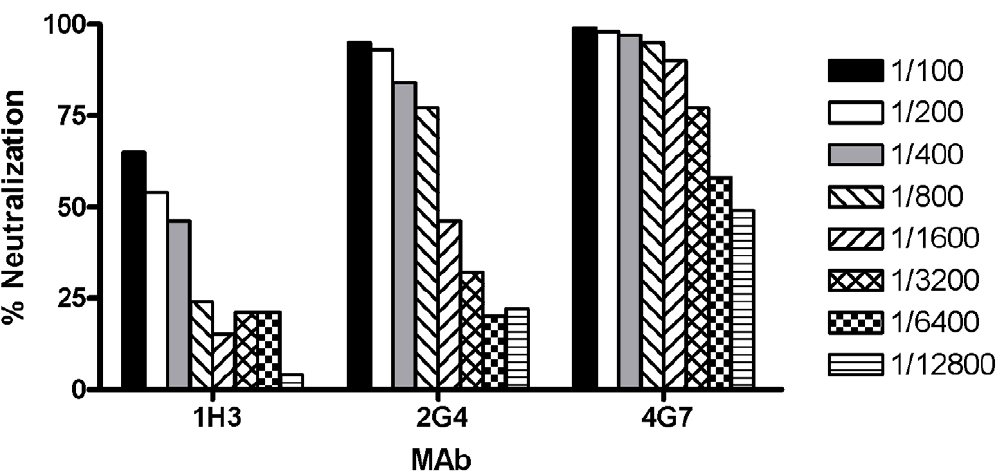
Figure 1. PRNT 50 assayforMAbs . ZEBOVGP-specific MAbs were serially diluted, and added to an equal volume of VSV D G/ZEBOVGP for 1 hour at 37 u C before adding to a confluent 12 well tissue culture plate seeded with Vero E6 cells. After 2 days the plaques were stained and counted. The percent reduction was calculated by determining the percent reduction in plaques at each dilution in comparison to the positive control (virus with no antibody). The assay was performed in triplicate.